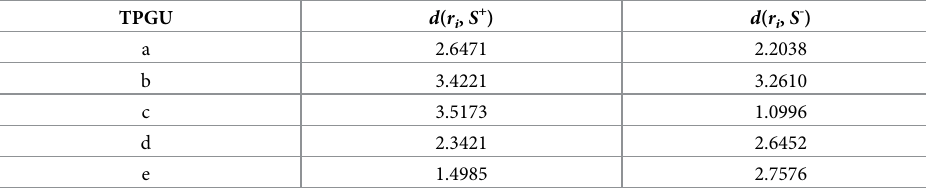
Table 4. Mahalanobis distance from each TPGU to the positive and negative ideal